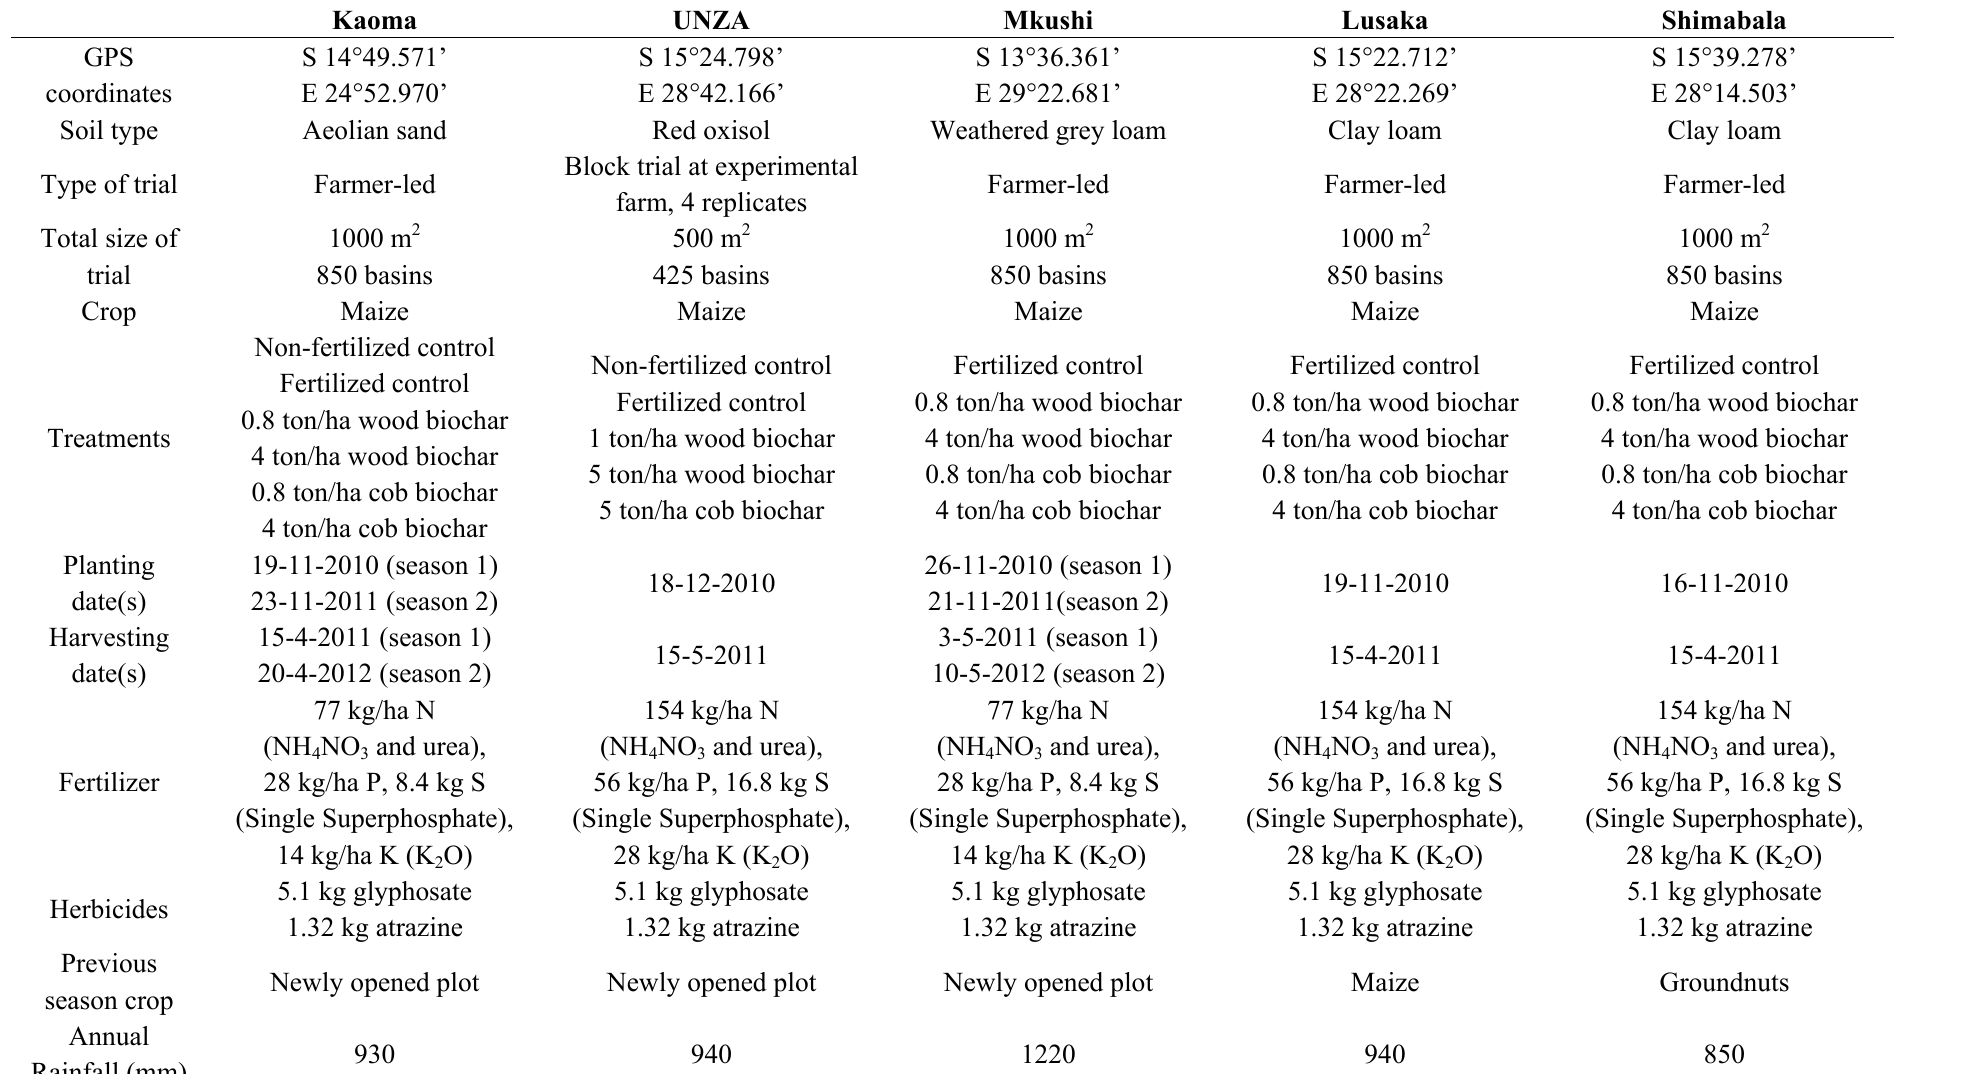
Table 1. Overview of field